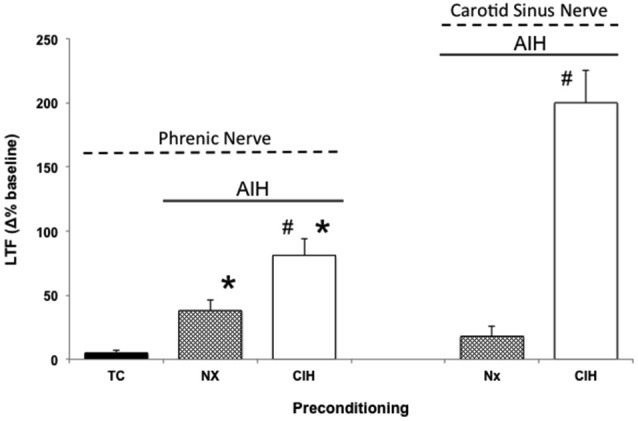
Metaplasticity in AIH induced pLTF and carotid (chemo)sensory long-term facilitation (csLTF) following preconditioning with chronic intermittent hypoxia (CIH). On left, time controls (TC) are without AIH, and no pLTF is observed. In contrast, AIH elicits pLTF in rats pretreated with both normoxia (Nx) and CIH (*p < 0.05 vs. TC). However, AIH-induced pLTF is greater in rats preconditioned with CIH vs. Nx (#p < 0.05 vs. Nx), demonstrating meta-plasticity in pLTF (data from Ling et al., 2001). On right, sensory recordings of the carotid sinus nerve reveal no csLTF in rats exposed to AIH following Nx preconditioning (post 60 min). However, after CIH preconditioning, robust csLTF is observed, revealing a form of plasticity not present in normal rats (i.e., metaplasticity; data from Peng and Prabhakar, 2003).